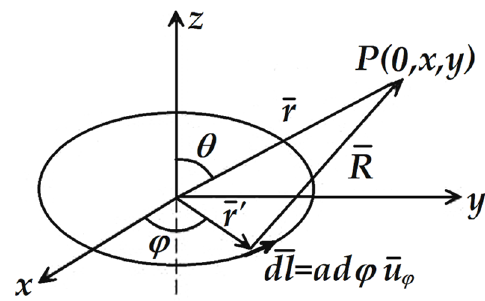
Figure A2. A circular loop of radius a , lying in the x – y plane, centered at the origin, and carrying a current I .